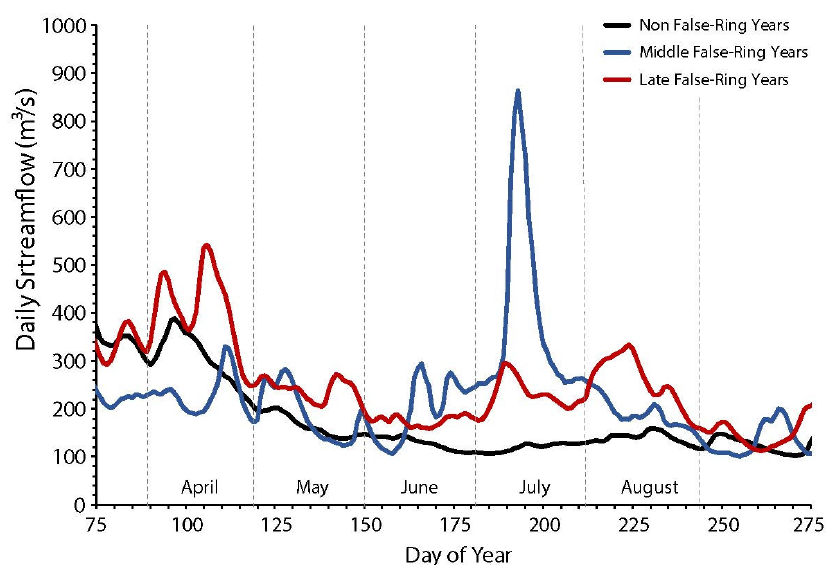
Figure 6. Average daily streamflow (day of year) for non-HFR years (black line), HFR years classified as “middle” (blue line) and “late” (red line). Note the middle-years’ July peak is especially pronounced due to the effect of Tropical Cyclone “Alberto” in 1994.